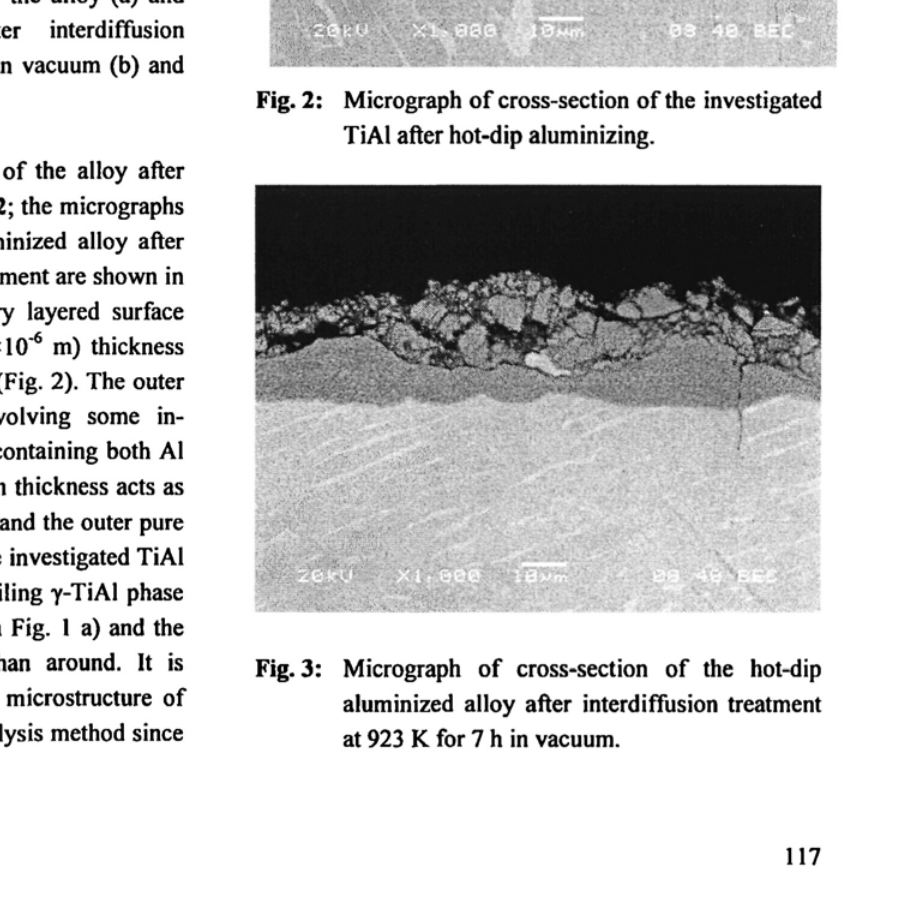
: X-ray diffraction patterns of the alloy (a) and the hot-dip coatings after interdiffusion treatment at 923 K for 7 h in vacuum (b) and air(c). Fig. 2: Micrograph of cross-section of the investigated